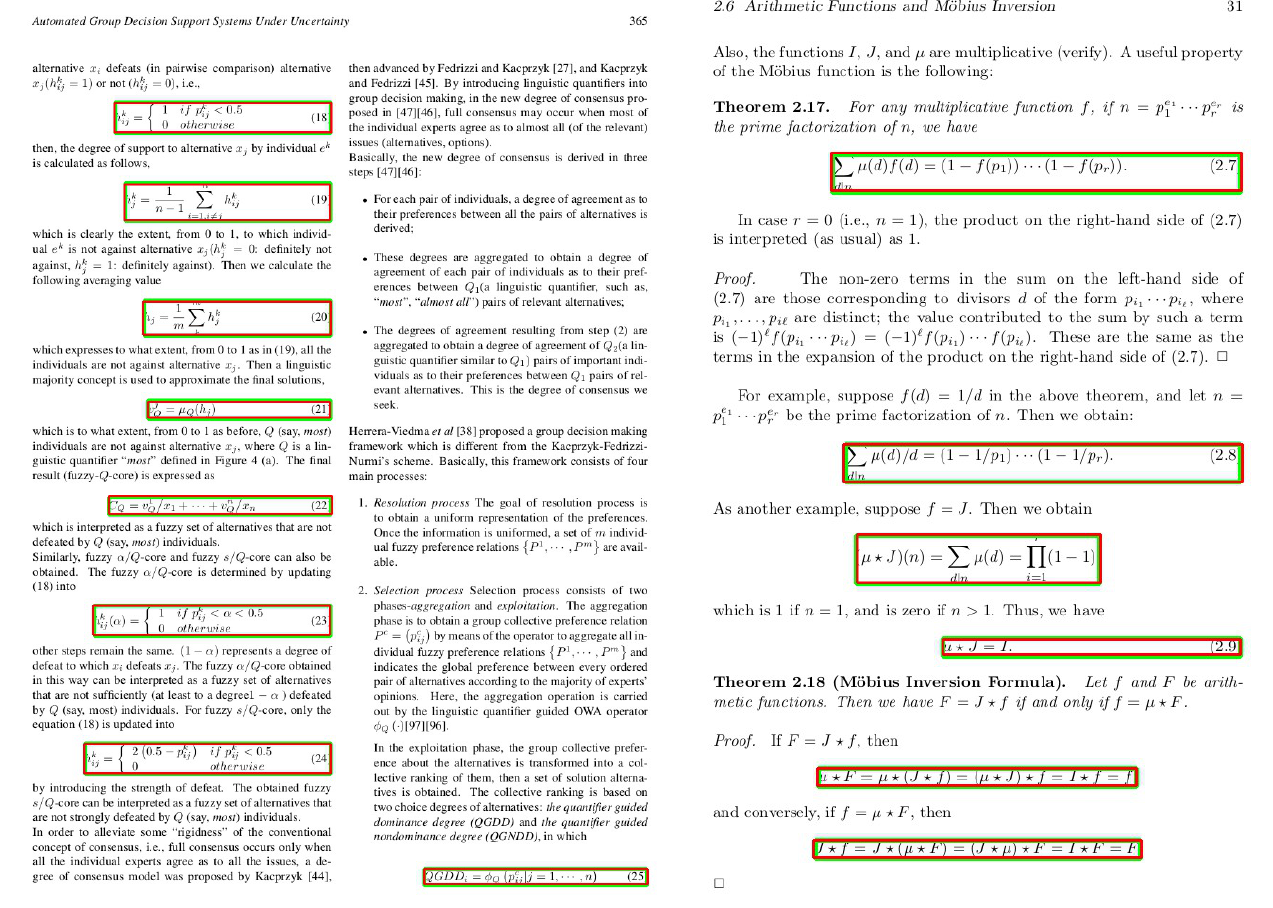
Figure 8. Performance evaluation of the proposed method on the ICDAR-2017-POD dataset. The green colour depicts the ground truth, while red denotes the predicted bounding boxes. ( a , b ) exhibit true positives on a two-column and a single column document image,